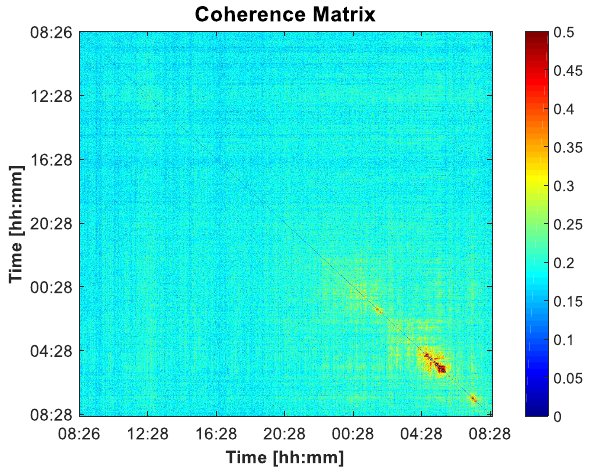
Figure 9. Long-term coherence matrix of the target considered in Figure 8.